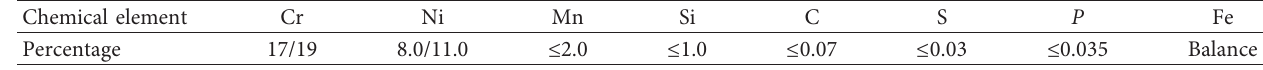
Table 1: Chemical composition (wt.%) of 304 stainless wire.